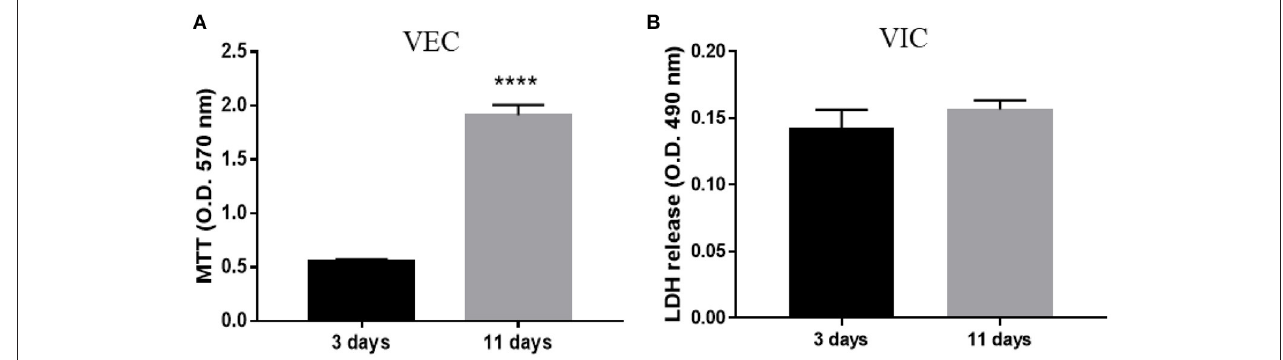
FIGURE 2 | Biocompatibility of ARdH with valvular cells. (A) Viability of VEC after 3 and 11 days of culture. The number of VEC was significantly increased after 11 days compared with 3 days of culture. (B) Total LDH measurements: the graph shows the level of LDH released by VIC encapsulated in the ARdH construct. There are no changes in the LDH levels at 3 days compared with 11 days (**** p < 0.0001, n =